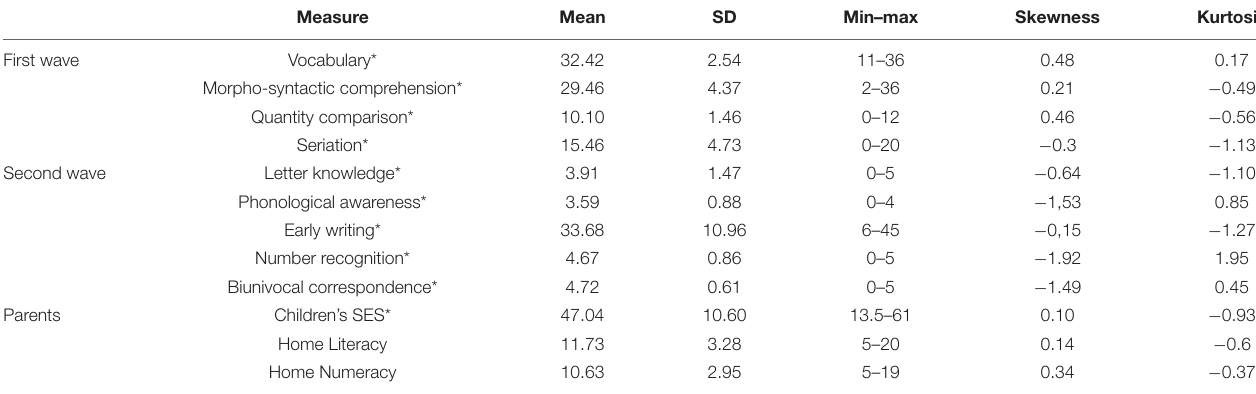
TABLE 1 | Descriptive statistics of measures included in the